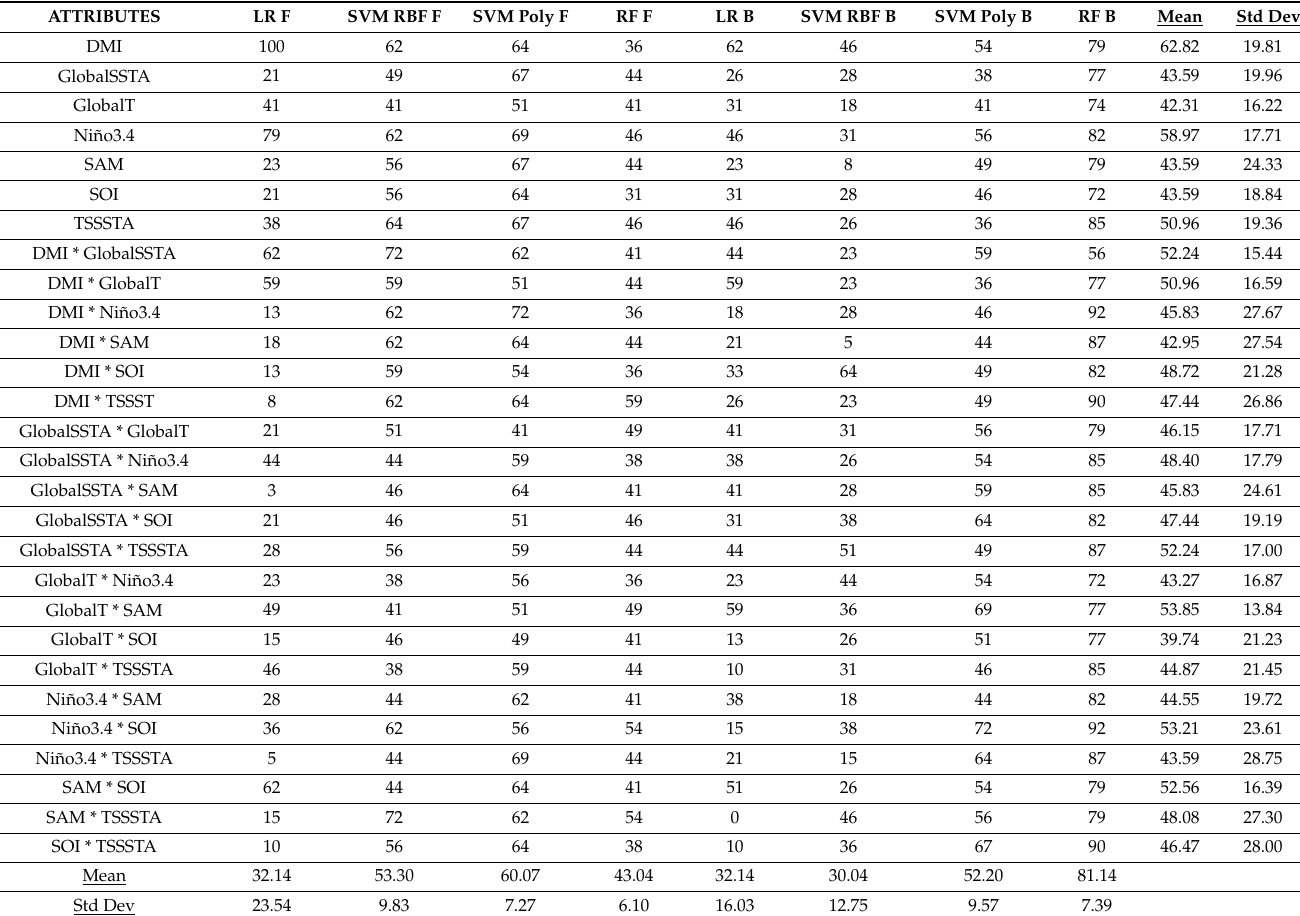
Table 6. Attribute selection for Richmond data using the eight different ML techniques. The percent- age of expanding windows selecting the attribute is shown for each of the eight methods (columns 2–9). The mean and standard deviation for rows and columns is shown. Attributes are ranked from highest to lowest